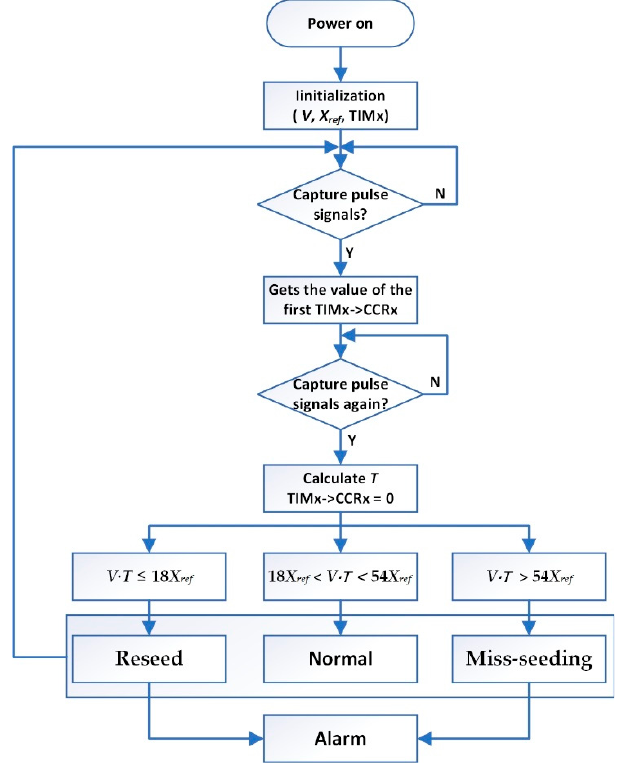
Figure 10. Seed condition monitoring process.